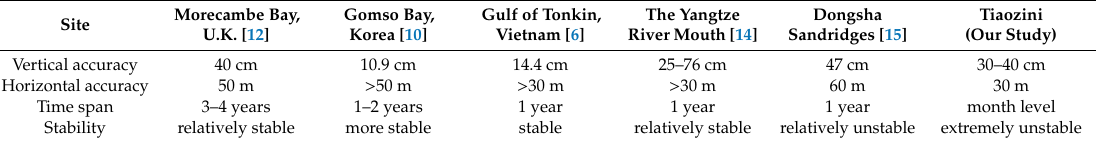
Table 3. Comparison of di ff erent tidal flats sites in topography monitoring according precious